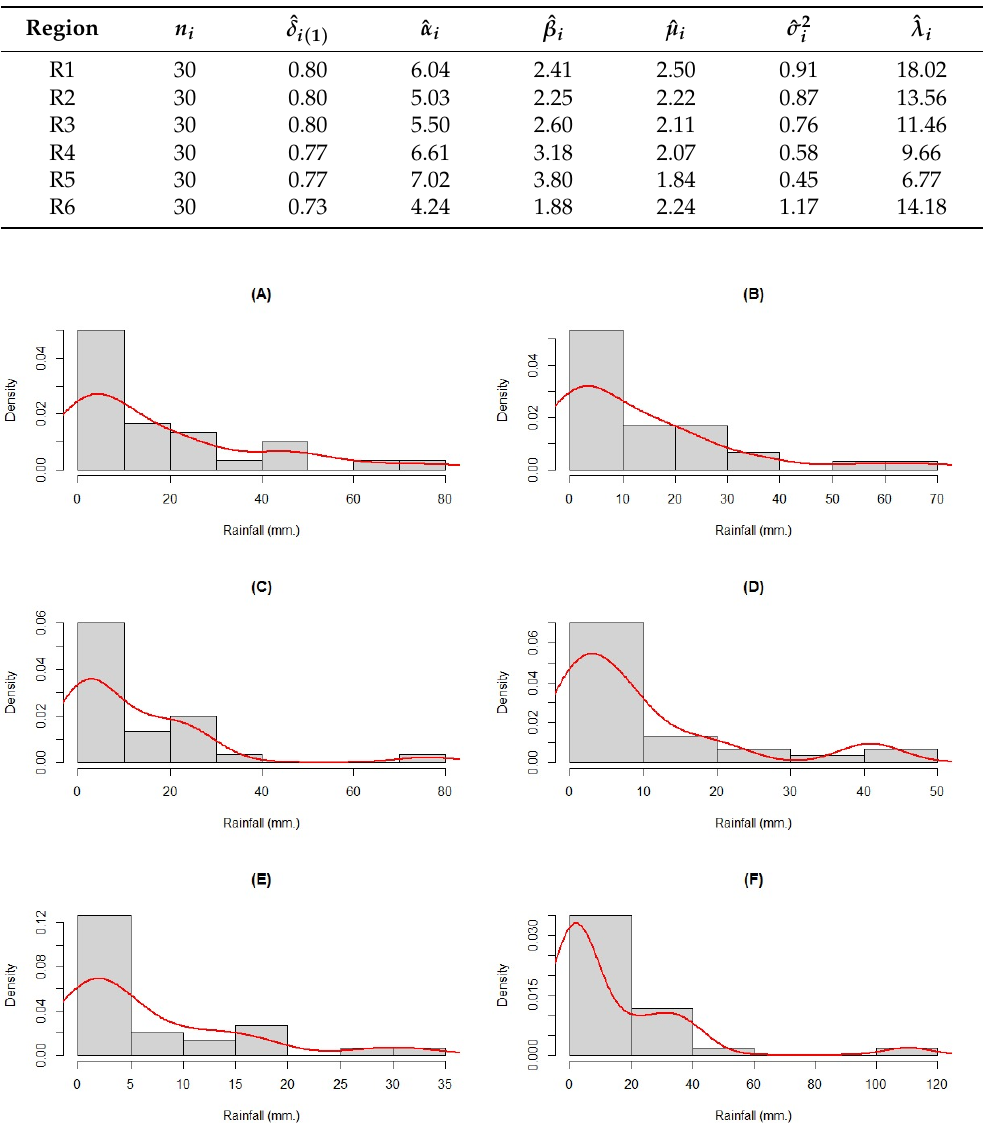
Table 7. Parameter estimates for the six regions in Thailand.